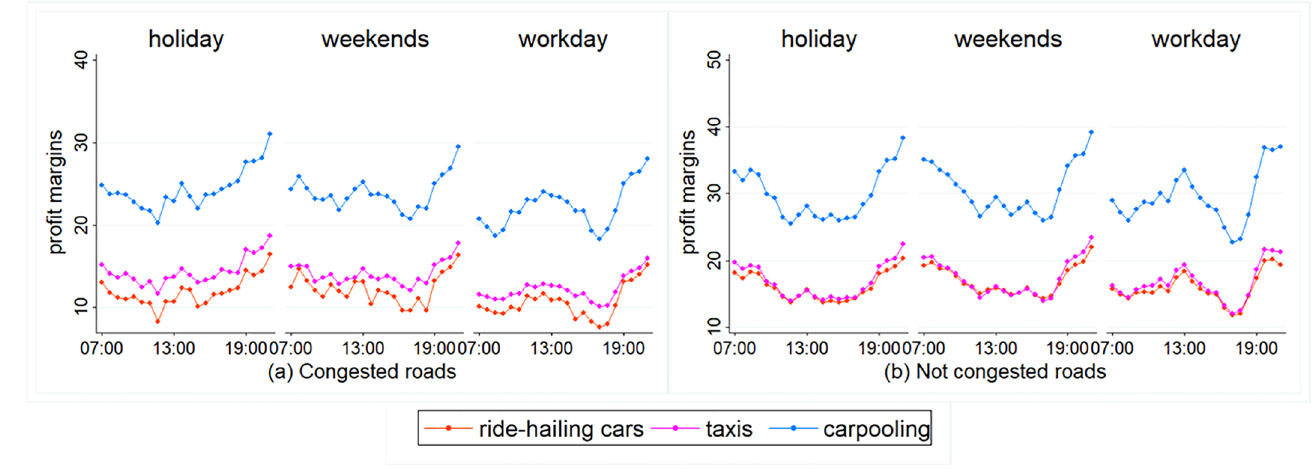
Fig 4. Comparing the effects of congestion of profit